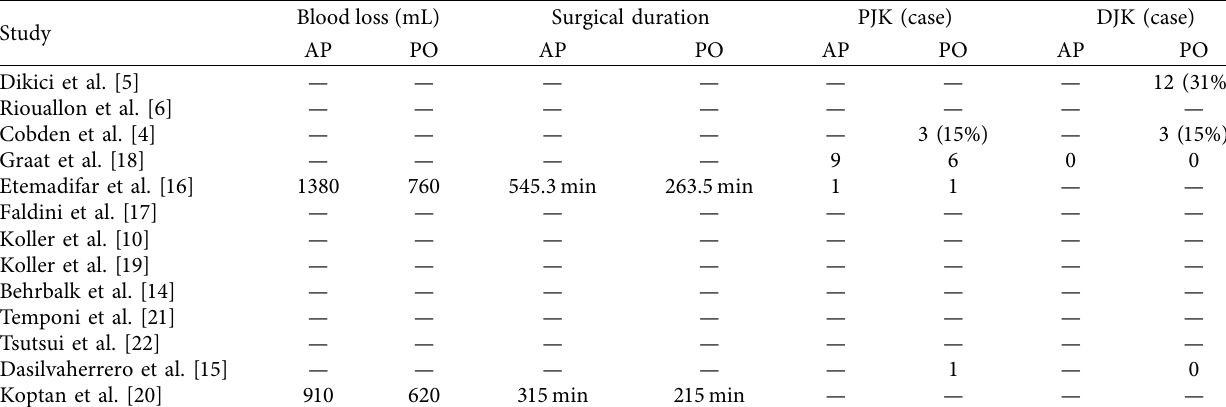
Table 4: Other information of the patients in all included